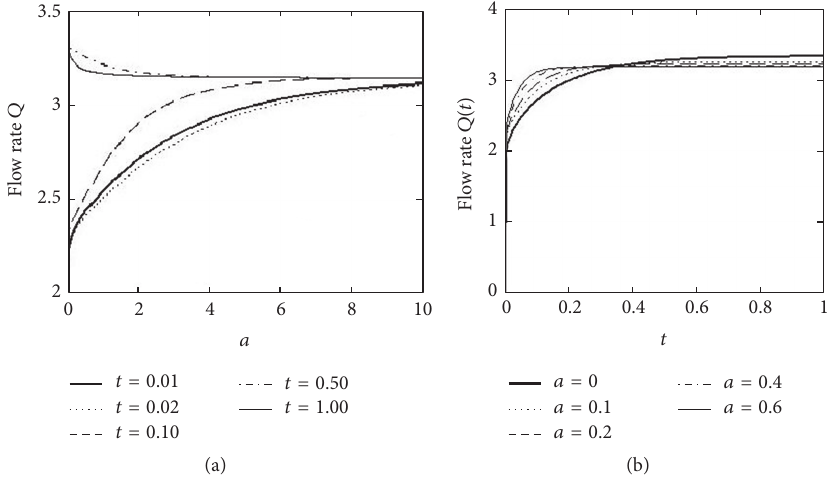
Figure 3: Variation of flow rate with the scale parameter 𝑎 , respectively, with the time 𝑡 .